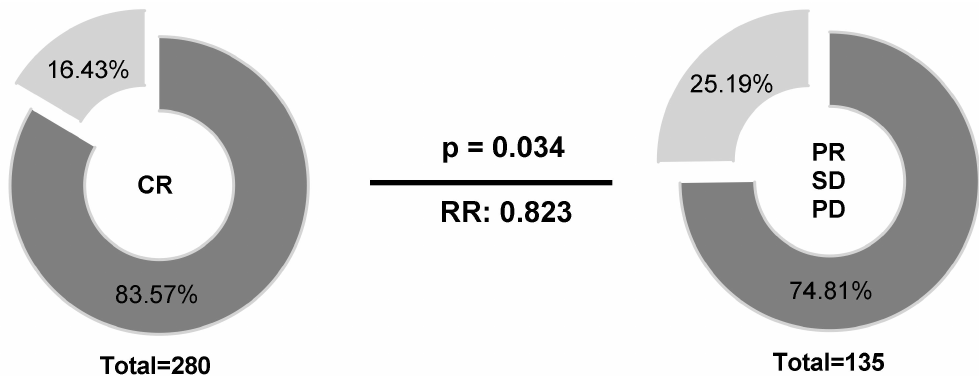
Figure 4. Association of the HLA-E*01:01 allele carrier status according to therapy response. Higher frequencies of HLA-E*01:01 allele carriers could be observed in patients with CR compared to patients with limited therapy response. HLA-E*01:01 / 01:01 or HLA-E*01:01 / 01:03 , dark grey; HLA-E*01:03 / 01:03 ; light grey; PD = progressive disease, SD = stable disease, PR = partial remission, CR = complete remission; Clinical data were available for 415 out of 441